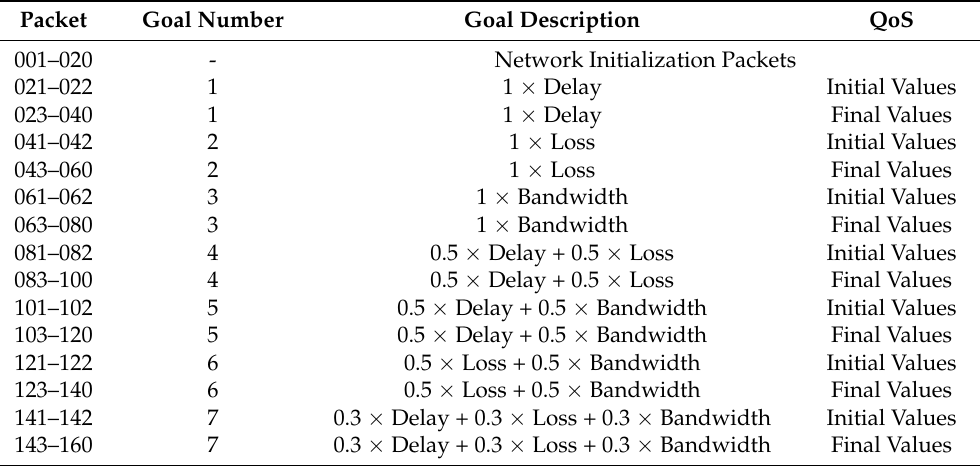
Table 3. QoS Deep Learning Cluster Validation (3 × 3 Nodes)—Simulation Parameters.